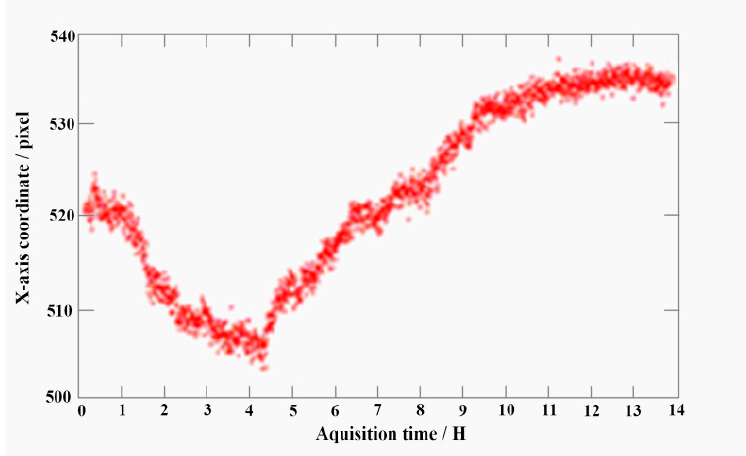
Figure 21. Result of data change caused by thermal deformation.